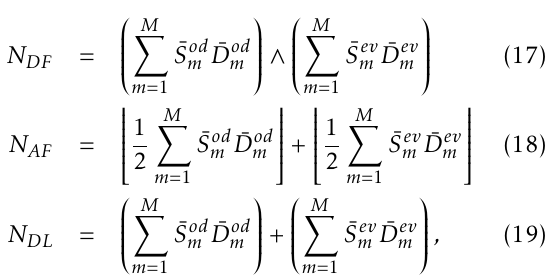
Table 2. Simulation Parameters and Values